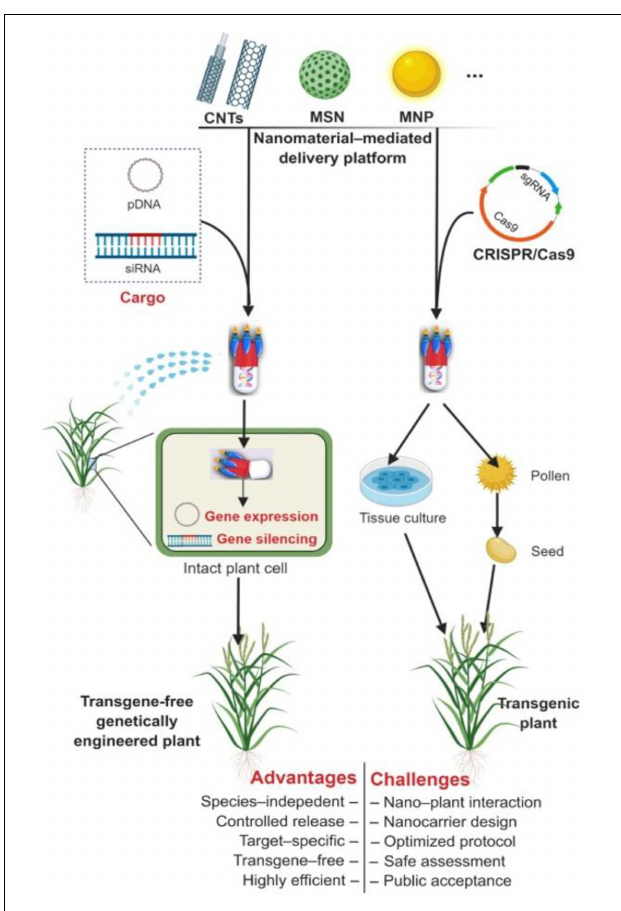
FIGURE 4 | Nanomaterial-mediated plant genetic engineering. Functionalized nanomaterials can provide a delivery platform that is capable of traversing barriers (e.g., multilayered cell walls) to deliver exogenous plasmid DNA (pDNA) and siRNA into intact plant cells. CNTs, carbon nanotubes;